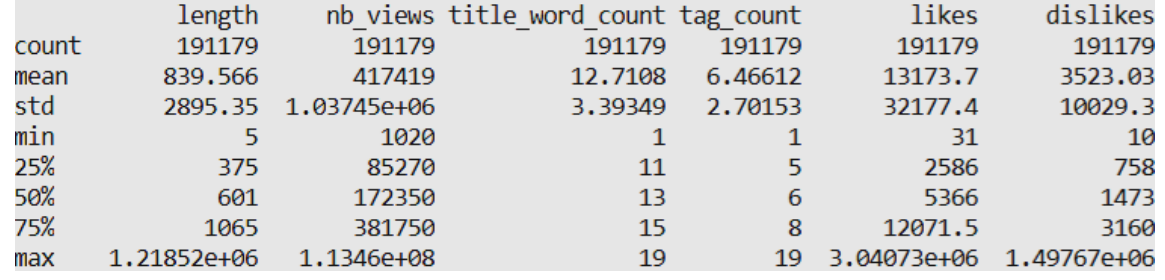
Figure 3. Summary Statistics of Numerical Data in